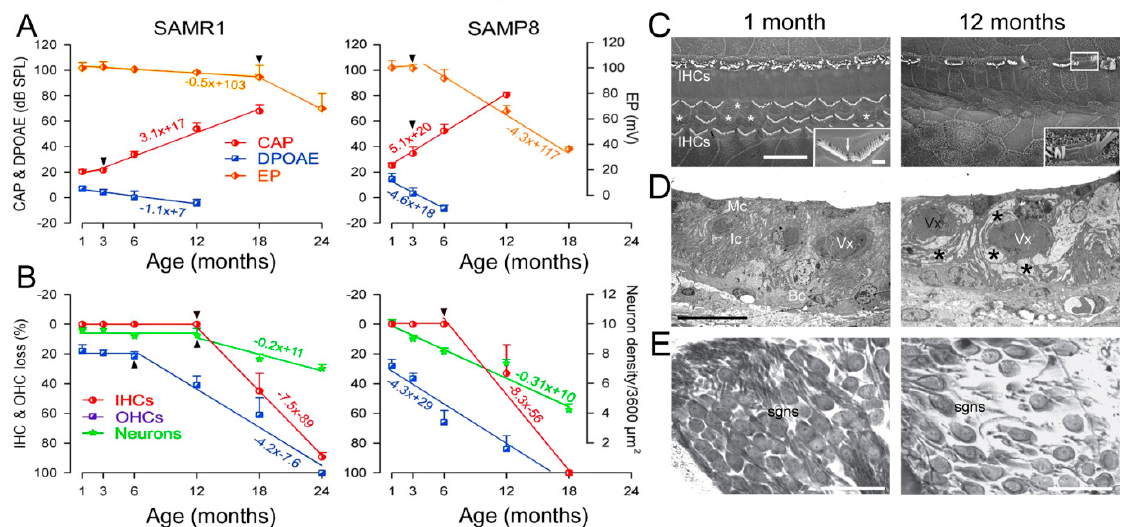
Figure 4. Functional and morphological assessments in SAMP8 and in SAMR1 mice. ( A ) Functional assessment. The compound action potential (CAP) threshold (red line) and distortion product otoacoustic emissions (DPOAE) amplitude (blue line) evoked by 20 kHz tone bursts, and endocochlear potential (EP) recordings (orange line, right axis)) in SAMR1 and SAMP8 mice. Fifty SAMP8 mice (n = 10 per age: 1, 3, 6, 12, 18 months) and 60 SAMR1 (n = 10 per age: 1, 3, 6, 12, 18, 24 months) mice were used for functional assessment. The lifespan of SAMR1 and SAMP8 was approximately 30 and 20 months, respectively. Note the earlier and faster increase in CAP threshold and decrease in DPOAE amplitude and EP value (arrowheads indicated broken-stick nonlinearities) in the SAMP8. In contrast to SAMR1, no CAP threshold nor DPOAEs could be recorded in 12-month-old SAMP8 mice, respectively. ( B ) Morphological assessment. Age-related loss of inner hair cells (IHCs, red line), outer hair cells (OHCs, blue line), and spiral ganglion neurons (SGNs, green line, right axis). At the end of the functional assessment period, the cochleae were removed and prepared for hair cell counting using SEM (n = 5 per age per strain) and SNG using light microscopy (n = 5 per age per strain). ( C ) Scanning electron microscopy in one and 12 months SAMP8 mice. Few OHCs are lacking (asterisks) among the three rows, but all IHCs are present at 1 month. The higher magnification insert shows an OHC stereociliary bundle with missing sterocilia (arrow). In a 12-month-old mouse, all OHCs and numerous IHCs (asterisks) have disappeared. The white box indicates a damaged IHC stereociliary bundle. In the insert, enlargement of the same IHC stereociliary bundle shows fused stereocilia. Scale bar = 10 µ m; Insert in ( A ) = 1 µ m. ( D ) Electron transmission microscopy of the stria vascularis. At one month, the three layers of strial cells, marginal (Mc), intermediate (Ic), basal (Bc) cells, and the blood vessels (Vx) appear normal. At 12 months, enlarged intercellular spaces and perivascular edema (asterisks) are seen. Scale bar = 10 µ m. ( E ) Light microscopical evaluation of spiral ganglion loss. Shown is the normal aspect and density of neurons at 1 month, and a reduced number of spiral ganglion neurons at 12 months. Scale bar = 50 µm. (Adapted from Ménardo et al., [59]).